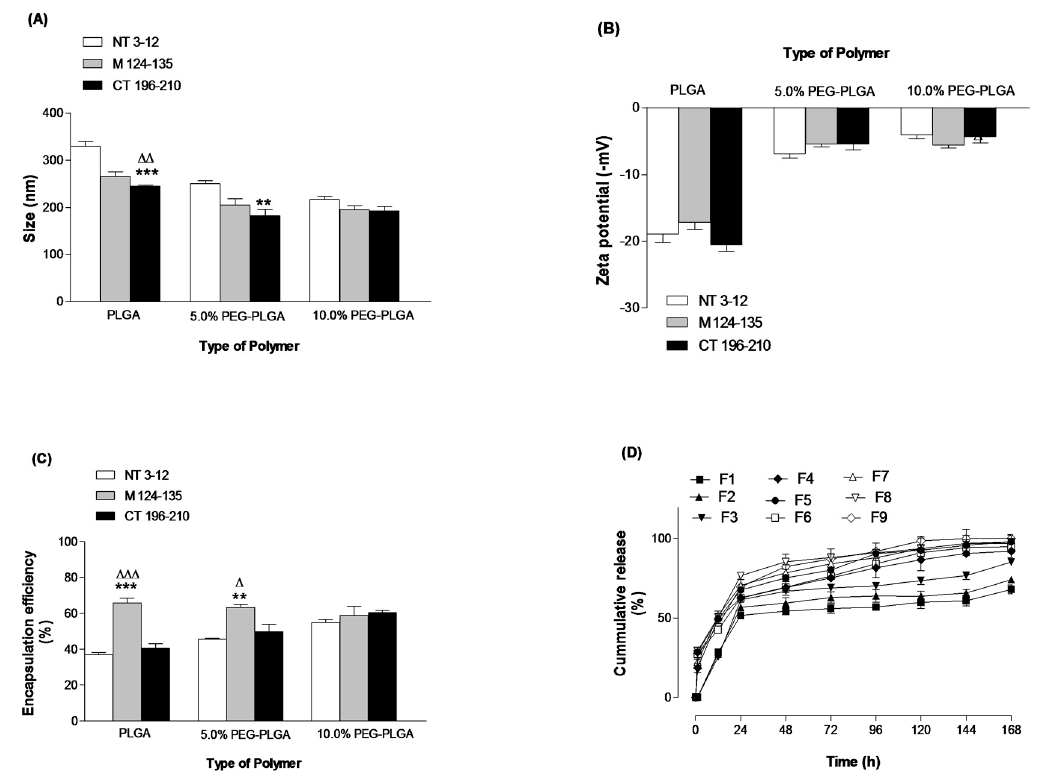
Figure 1. Effects of polymer type on size ( A ), zeta potential ( B ), encapsulation efficiency ( C ) and